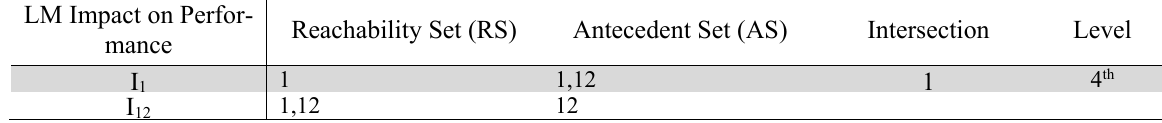
Fourth Level Partition LM Impact on Perfor-